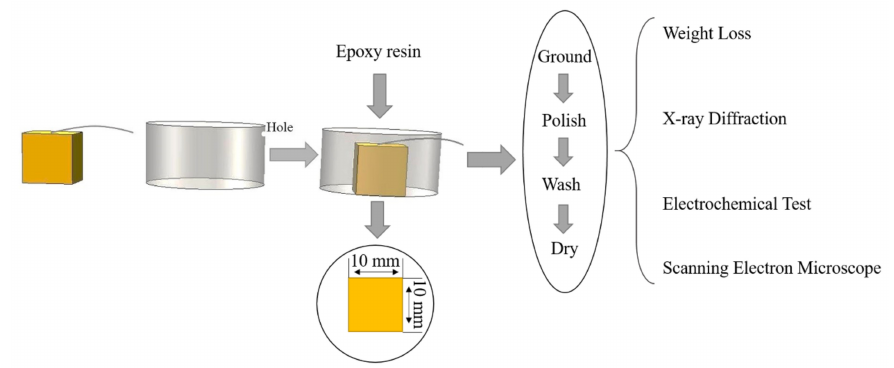
Figure 3. Specimen preparation